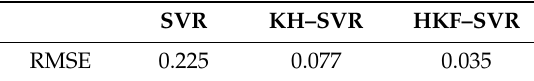
Table 7. Prediction errors comparison.